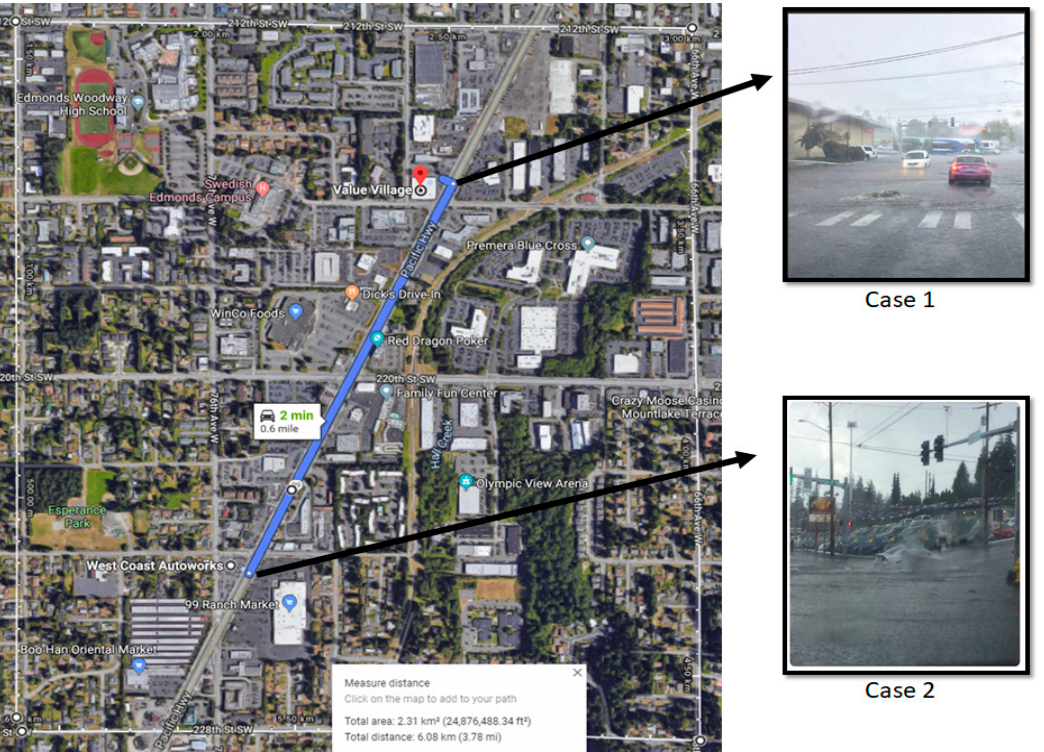
Figure 6. The location of the two manholes, which cause flood along a street (Case 2) and across a street (Case